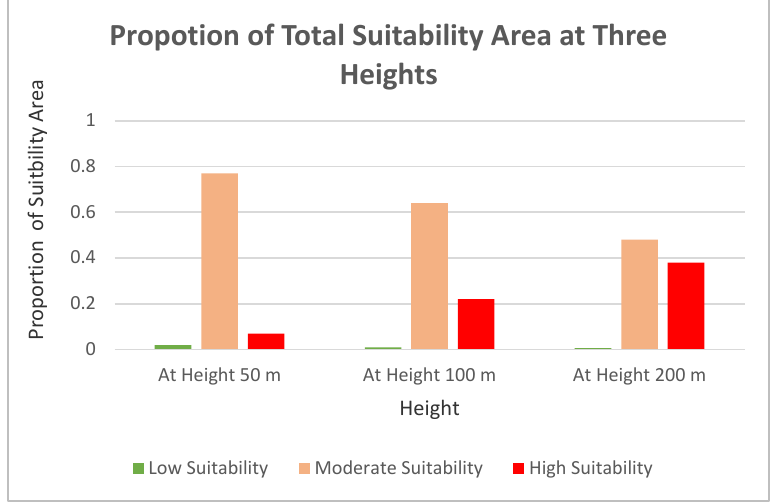
Figure 4. Land Area Percentage of total suitability area at three heights for the whole national area.